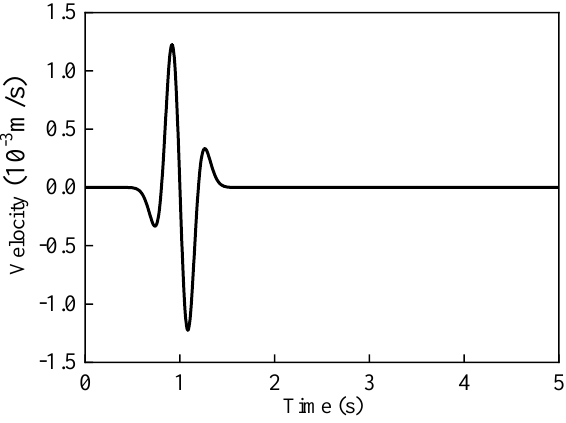
Figure 3. The velocity−time history.